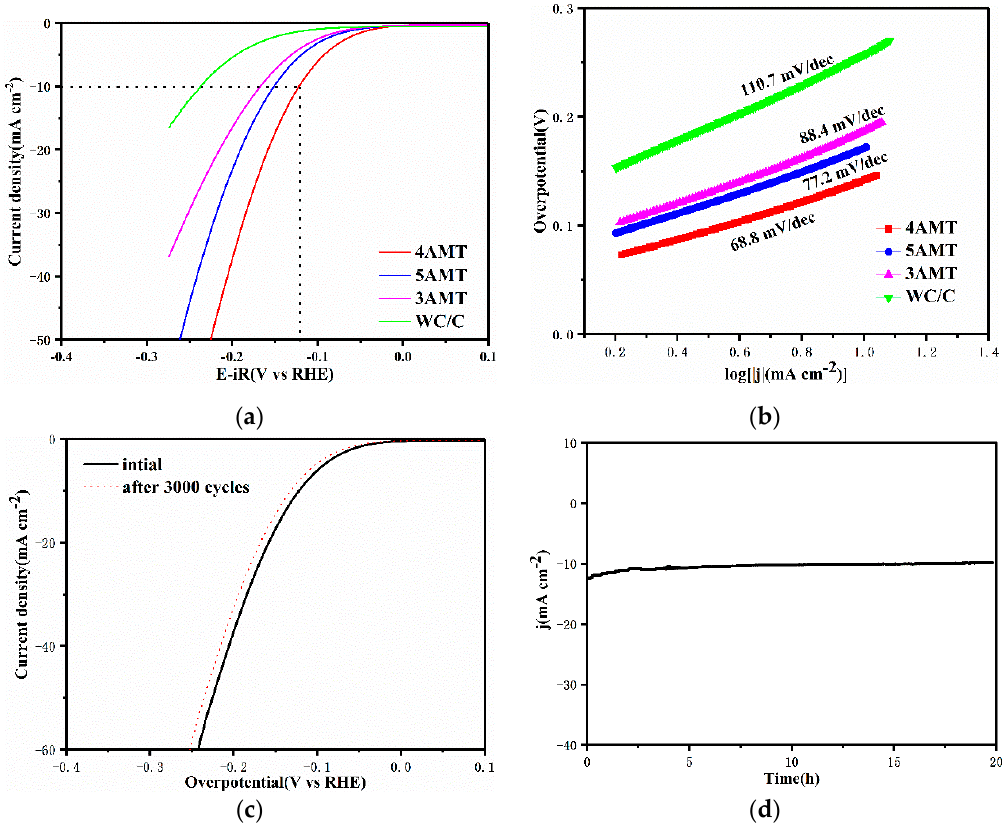
Figure5. ( a )LSVcurvesof4AMT,5AMT,3AMT,andWC / Cin1MKOH;( b )Tafelslopesgeneratedfrom ( a , c ) LSV curve of 4 AMT, before and after 3000 CV cycles; ( d ) i-t curve of 4 AMT with an overpotential of 130